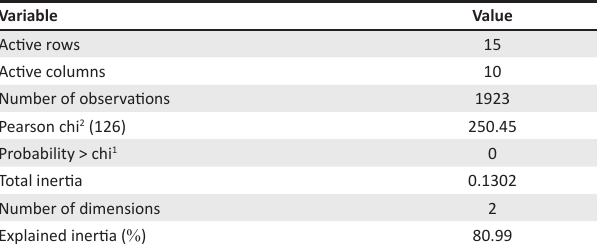
TABLE 1: Descriptive